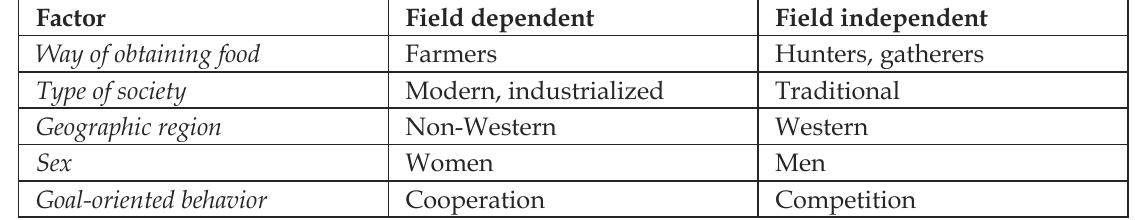
Tab. 2. The factors in (cid:223) uencing